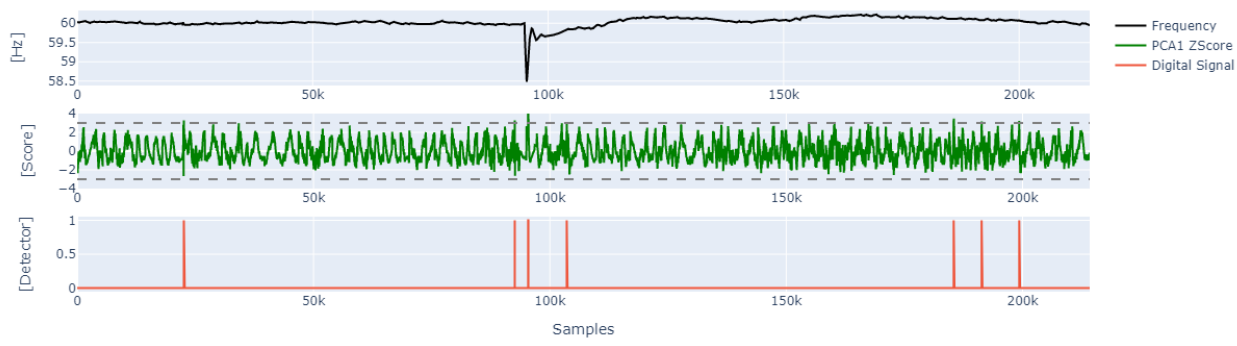
Figure 9. Event 1: detector event of PMU Cascavel (located at Parana State).